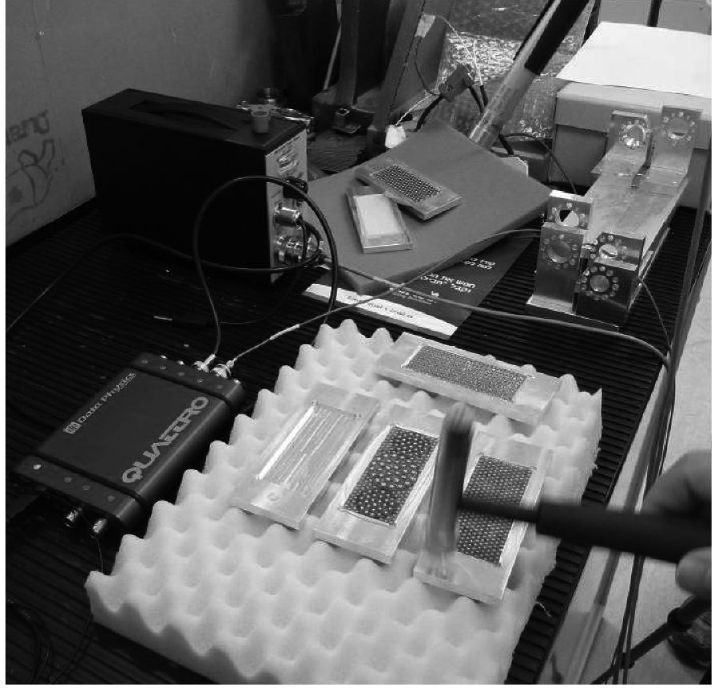
Fig. 68. Microphonics Experimental rig